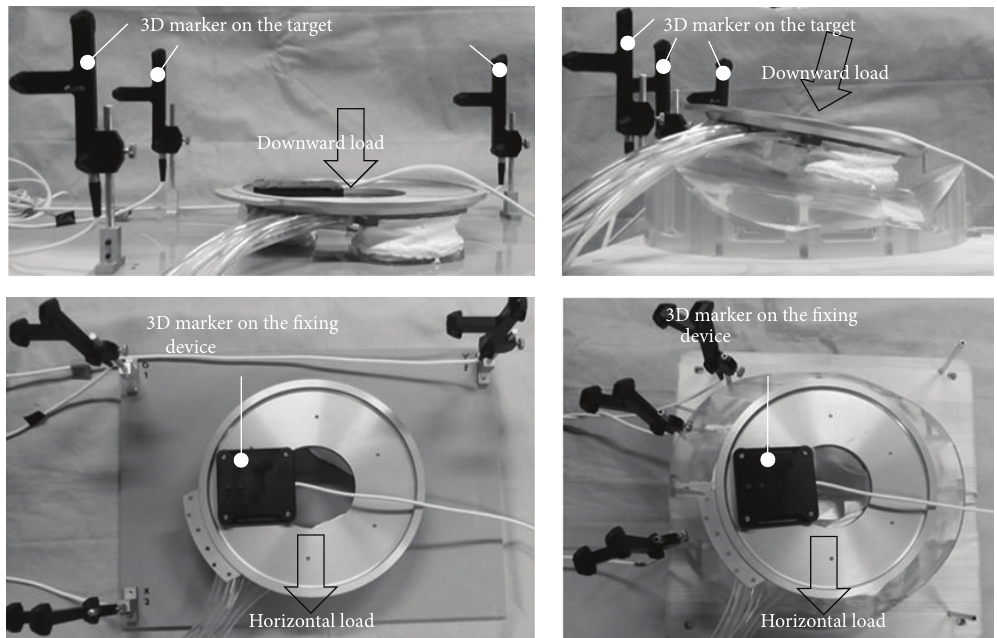
Figure 13: Experimental setup to evaluate the stiffness of the holding